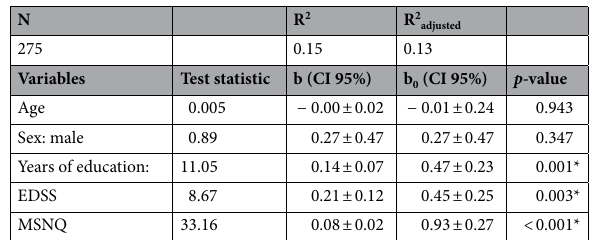
Table 4. Logistic regression analysis of the prediction of a positive screen for depression and/or cognitive impairment in the total population. Statistically significant predictors (p < 0.05) are marked with *. CI